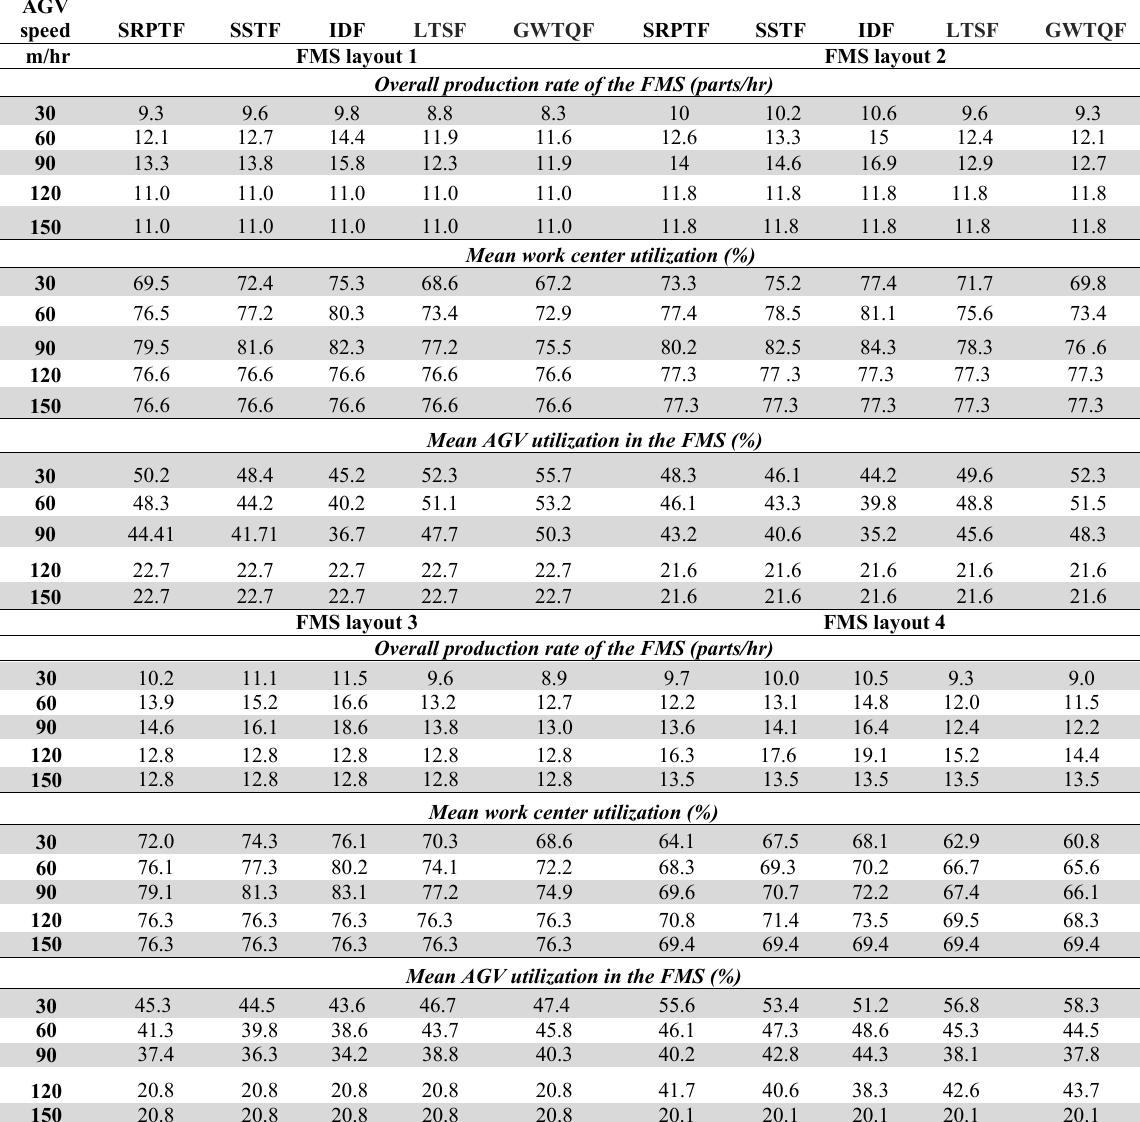
Simulation results of the layout 1, layout 2, layout 3 & layout